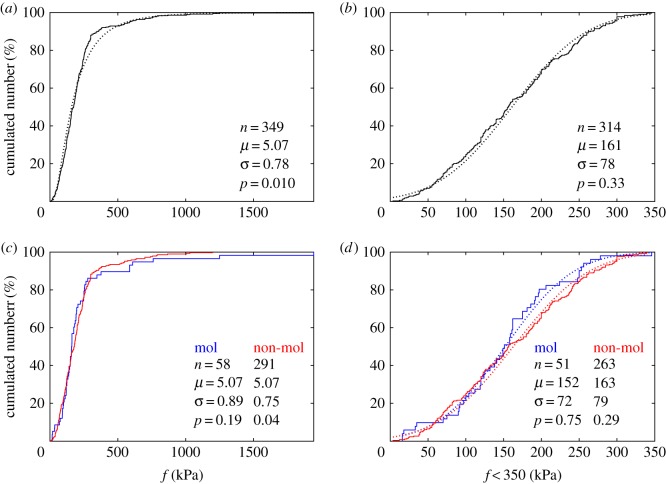
Distributions of specific tensions f. (a) Empirical cumulated distribution function (CDF). All f values are shown along the x-axis as stepwise increments, giving a complete and undistorted view of the original data. Empirical CDF is fitted to a lognormal distribution of mean µ and s.d. σ (dotted black line); fit is rejected at level 5% (p = 0.01). (b) Empirical CDF of f < 350 kPa (solid black line) with fitted normal distribution of µ and σ in kPa (dotted black line), not rejected at level 5% (p = 0.33). (c) Empirical CDFs of f for molecular motors (blue line, fitted lognormal not rejected) and non-molecular motors (red line, fitted lognormal rejected); the two distributions are not significantly different (p = 0.40). (d) Empirical CDFs (solid line) and fitted normal CDFs (dotted line) for molecular (blue line) and non-molecular (red line) motors with f < 350 kPa; µ and σ in kPa; the two distributions are not significantly different (p = 0.20). All comparisons based on Kolmogorov–Smirnov tests.